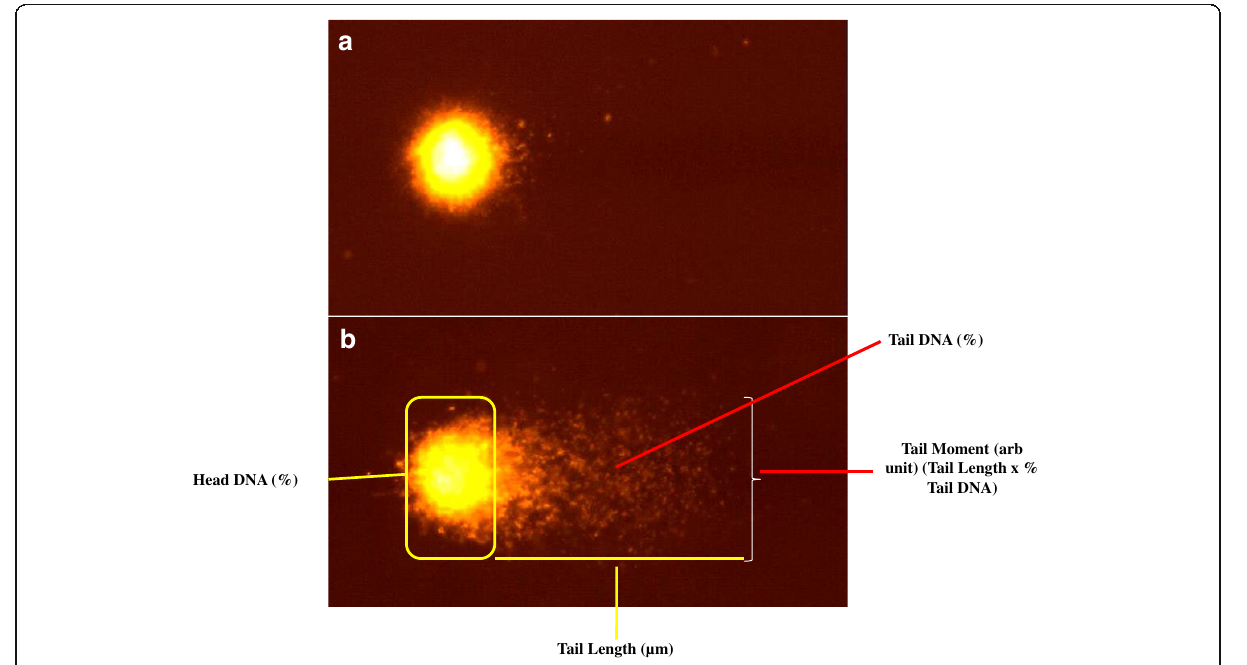
Fig. 2 Photomicrograph of single cell ( a ) Intact DNA; ( b ) Degraded DNA showing Comet parameters for DNA degradation